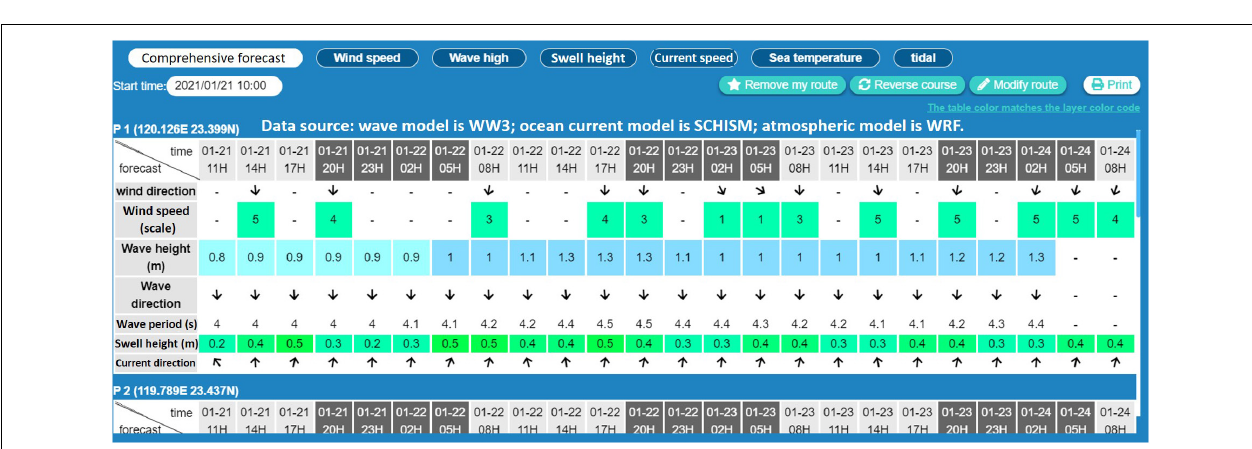
FIGURE 4 | List of sea states (wind, wave, current, and temperature) in the self-defined cruise. Data for next 72 h are shown. Figures of the data can be obtained when clicking the bottoms in the upper